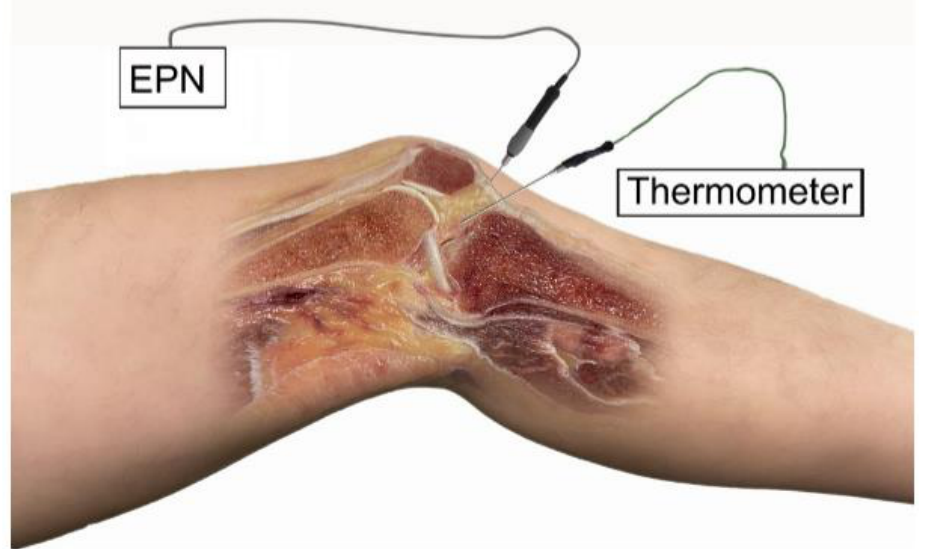
Figure 3. Application of percutaneous needle electrolysis on the infrapatellar fat pad of the knee on an anatomic sample.